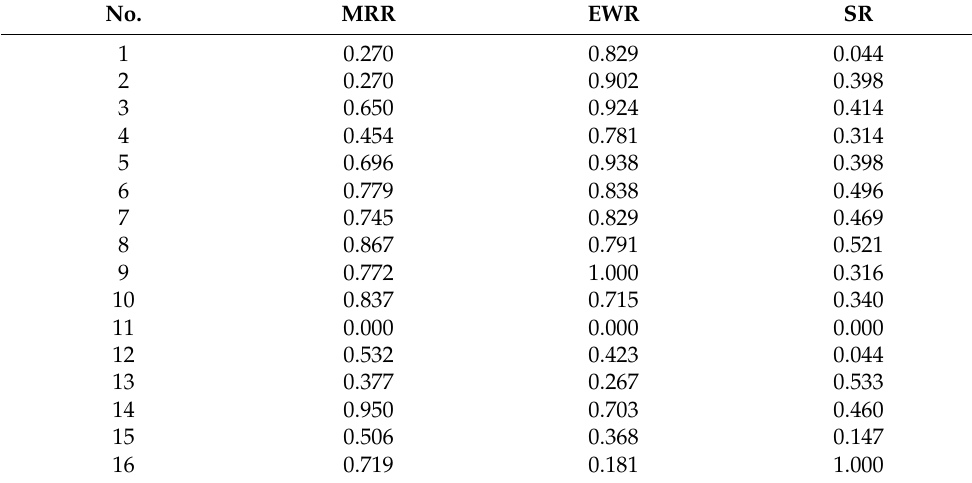
Table 9. Normalized decision matrix.